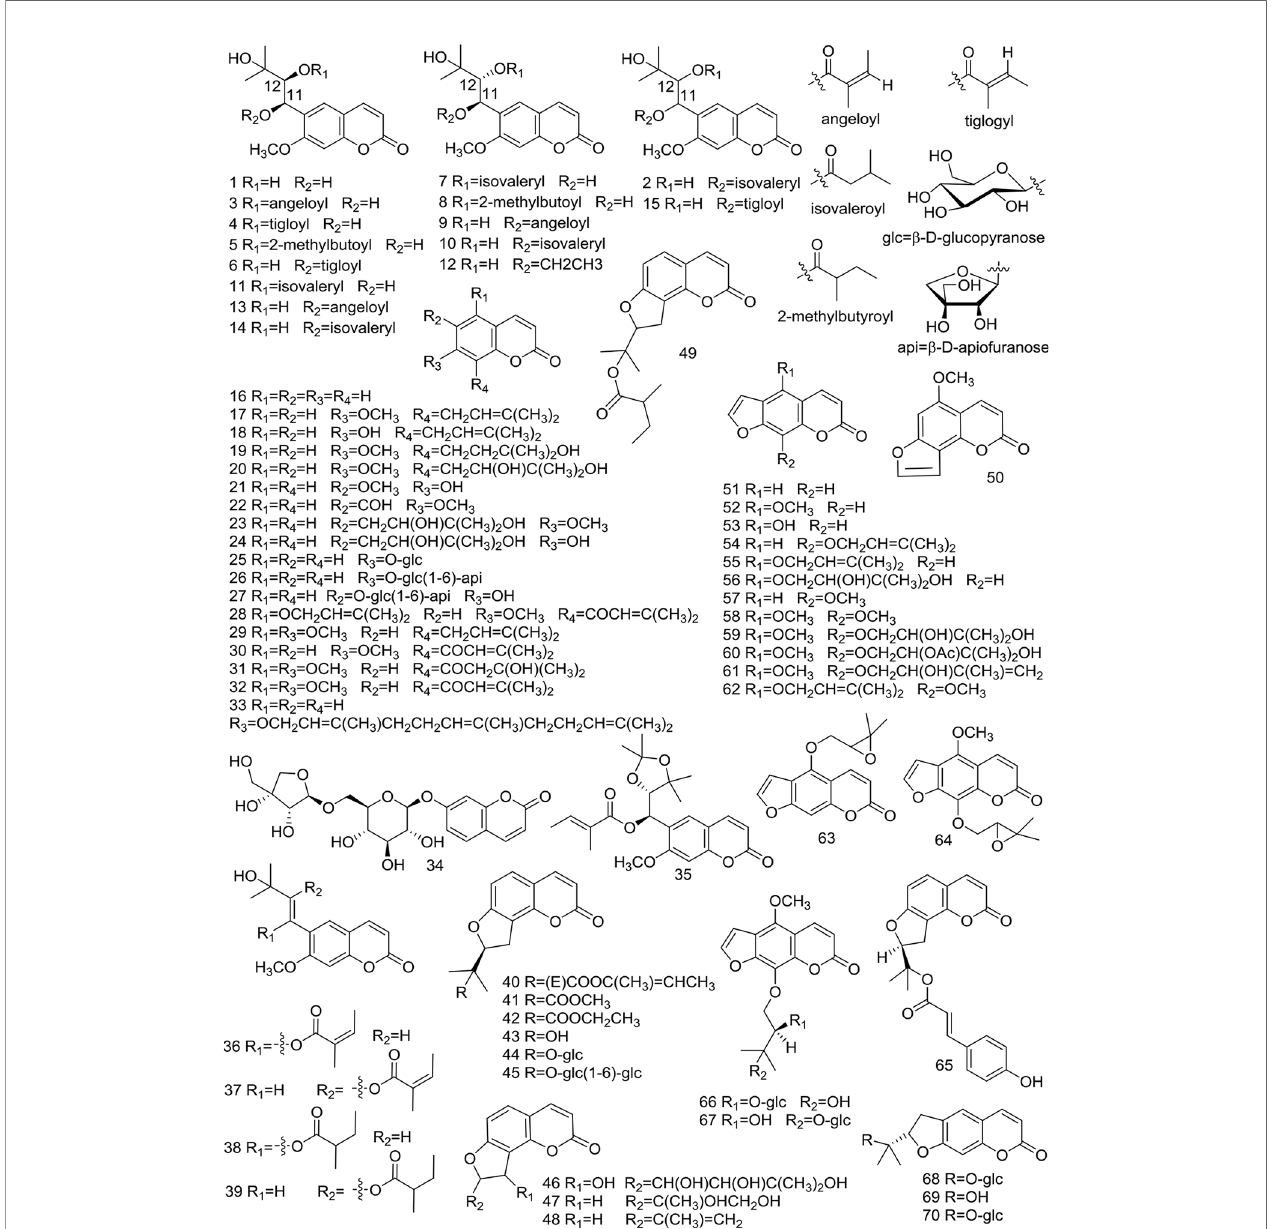
FIGURE 2 | Structures of coumarins (1 – 70) isolated from medicinal plants as